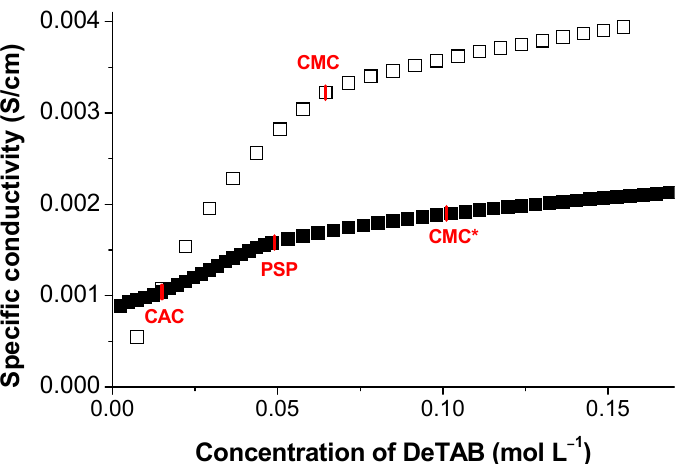
Figure 6. Specific conductivity of DeTAB at different concentrations in water (empty squares) and in an aqueous solution of 10 wt.% kraft lignin (full squares). The different transition regions high- lighted (i.e., critical aggregation concentration (CAC), polymer saturation point (PSP), critical micelle concentration (CMC), and apparent critical micelle concentration (CMC*)) are described in the text. Table 1. The CMC, CAC, and PSP of DeTAB for different initial concentrations of lignin obtained from the conductivity data at 25 °C.